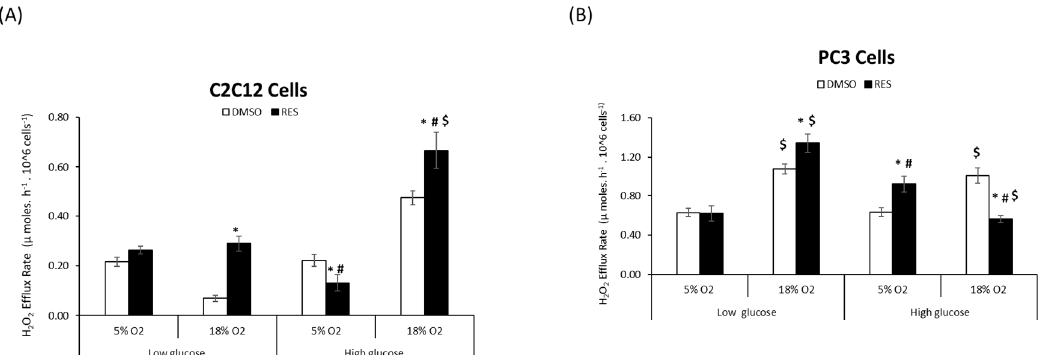
Figure 2. Media oxygen and glucose levels determine resveratrol’s effects on cellular hydrogen peroxide production. C2C12 ( A ) and PC3 ( B ) cells were cultured at either 5% O 2 or 18% O 2 in either low (5 mM) or high (25 mM) glucose DMEM. RES effects on H 2 O 2 production were modulated by oxygen and glucose levels in both C2C12 ( A ) and PC3 ( B ) cells. In all experiments, cells were treated for 48 h with 10 µ M RES (filled bars) or an equal volume of vehicle control (DMSO; open bars). Data shown are means ± SEM of at least 3 independent experiments ( n = 12). ‘*’ represents differences between RES-treated and DMSO-treated cells, p < 0.05. ‘#’ represents differences between low and high glucose levels, p < 0.05. ‘$’ represents differences between low and high oxygen levels.